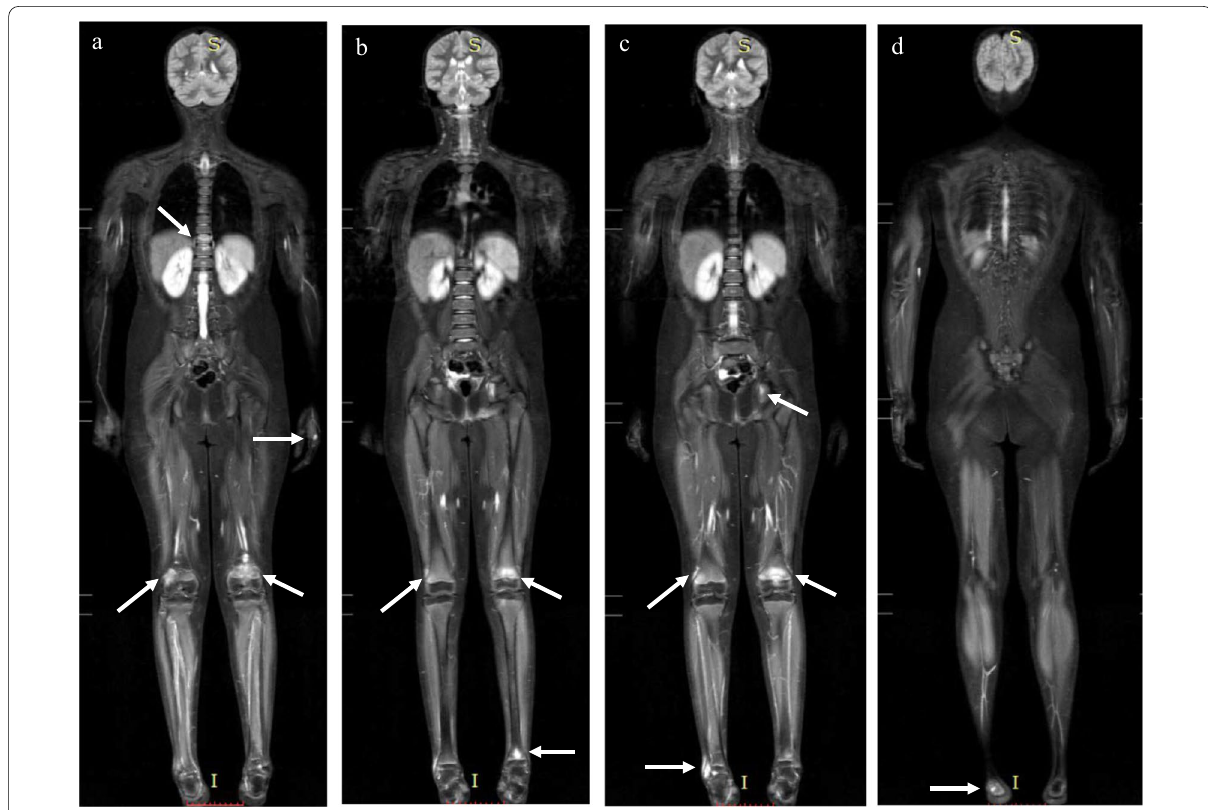
Fig. 8 CNO in an 8-year-old girl complaining of hip and leg pain. Whole-body MRI ( a – d ) depicted multifocal bone lesions at the distal metaphysis of both femurs ( a – c ), distal metaphysis of the left tibia ( b ) and right fibula ( c ), right calcaneus ( d ), left acetabulum ( c ), left metacarpal bone head ( a ) and bone marrow edema at a mid-thoracic vertebral body ( a ). The vertebral lesion was asymptomatic and its detection in a preclinical scenario may change the treatment approach and prevent